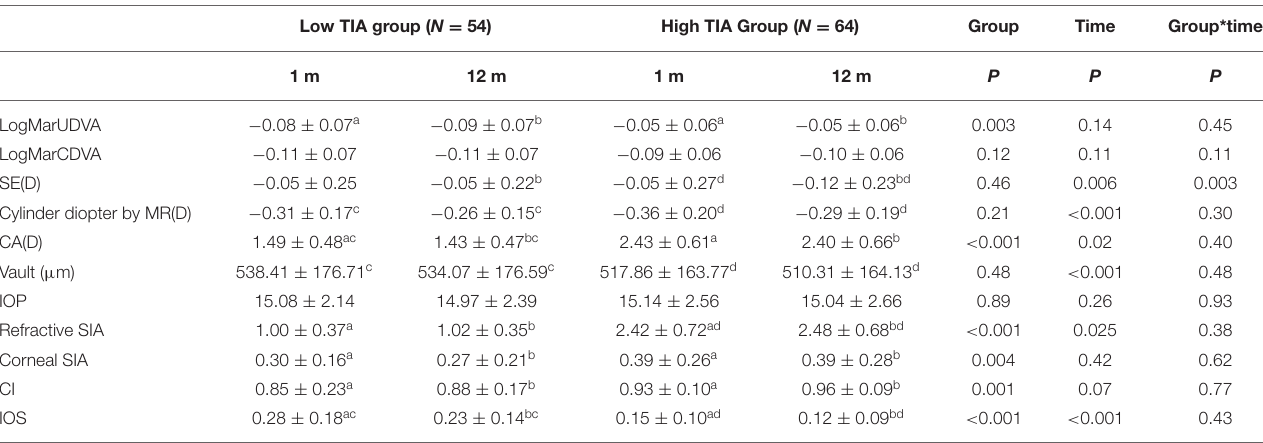
TABLE 3 | Postoperative comparison of low and high TIA